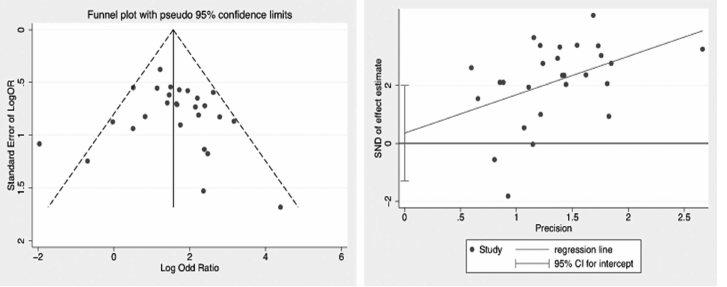
Fig 6. Funnel Plots of publication bias summaryfor corresponding Meta-analysis (left) and Egger’s publication bias plot with pseudo 95%CI (right)